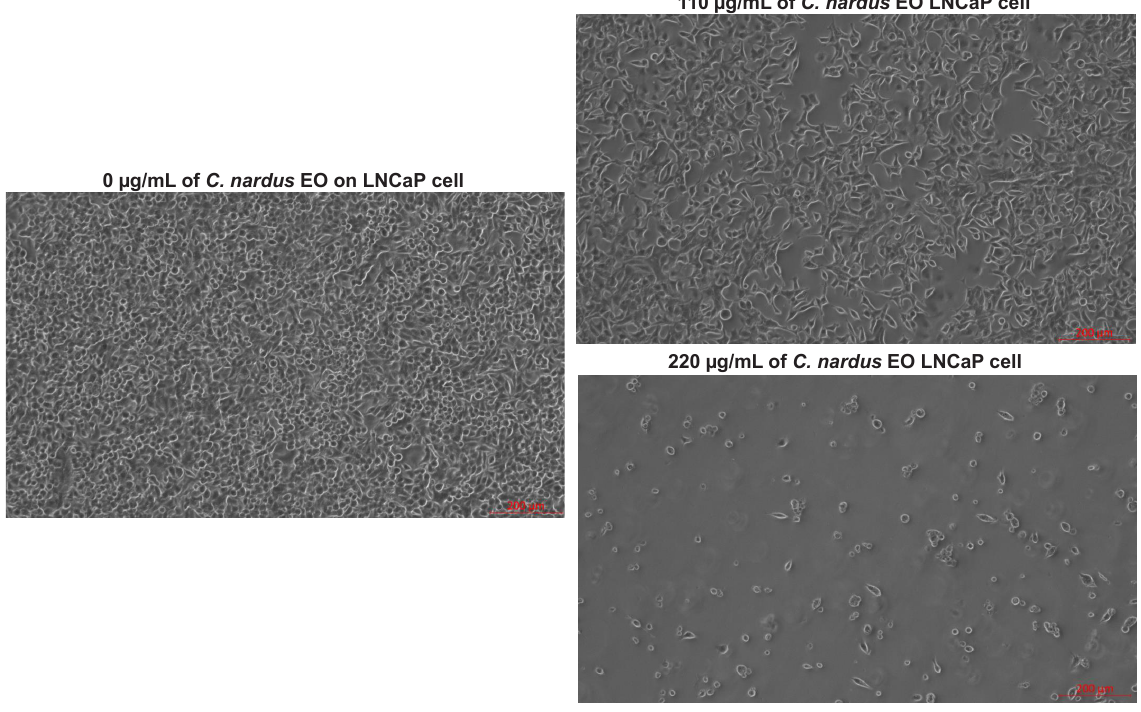
Figure 5: Action of C. nardus essential oil on the morphology of LNCaP